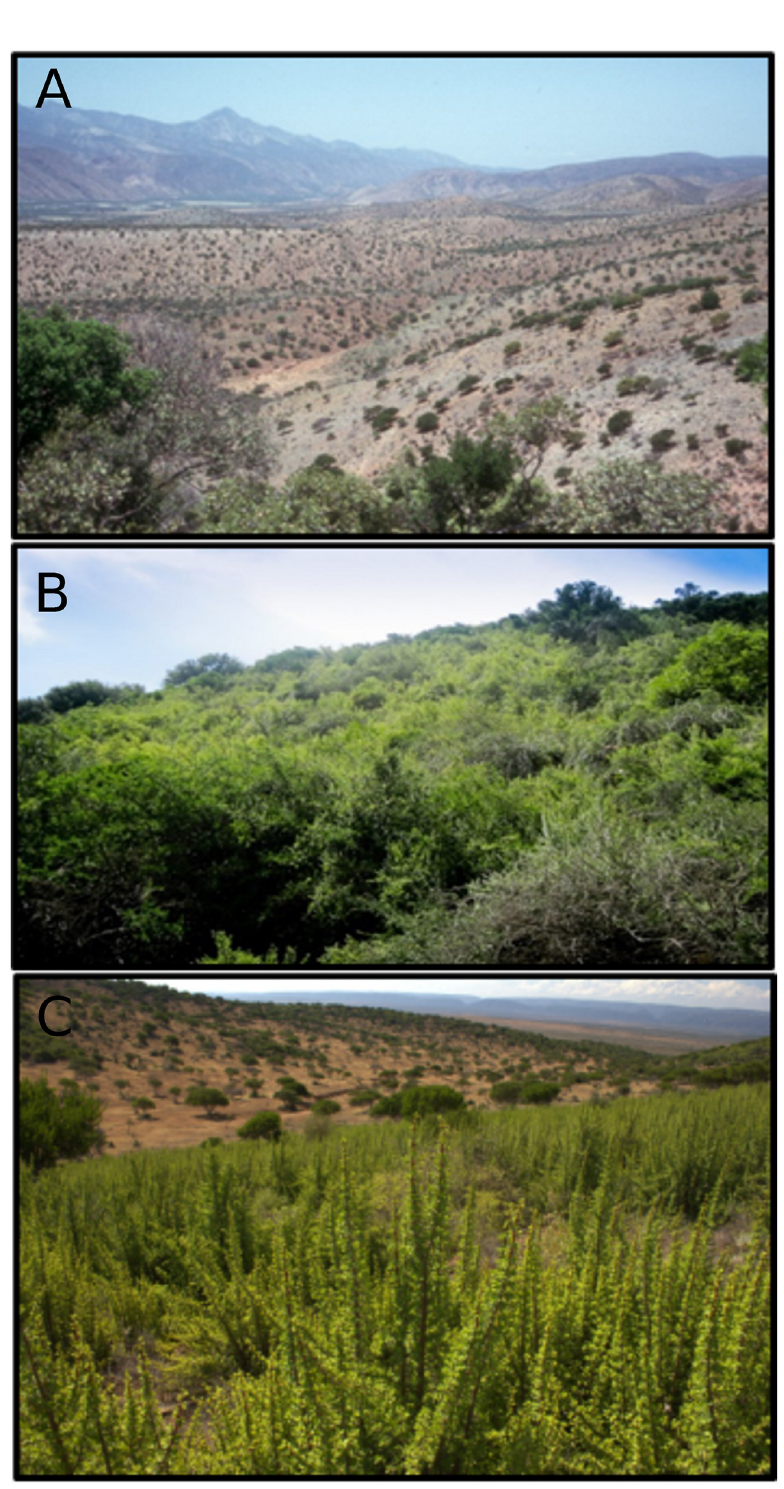
Fig 1. Degraded and intact spekboom sites compared with a 3-year old restoration site. A: a foothill landscape comprising livestock-degraded spekboom ( Portulacaria afra ) thicket where all spekboom has disappeared, leaving only woody canopy shrubs of Pappea capensis and Euclea undulata with a field layer of largely ephemeral plants. B: intact spekboom thicket (2-3 m tall) located in the same region as the top photo. Note the dense canopy of spekboom, scattered P. capensis trees on the skyline, and absence of bare ground (photos: RM Cowling). C: a thicket-wide